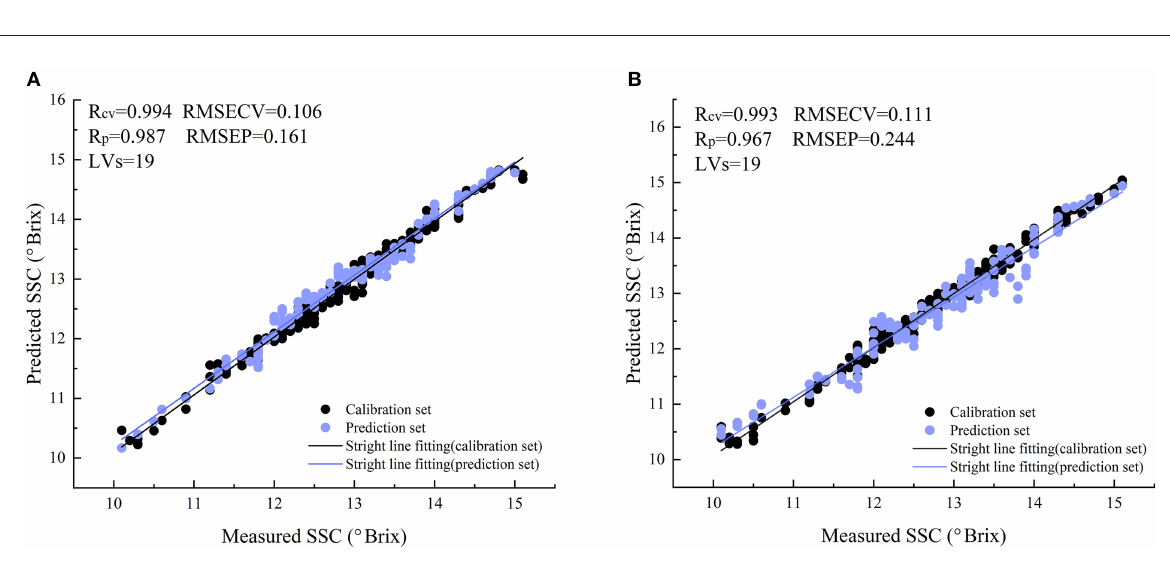
FIGURE7 The correlation diagrams between the measured values of SSC and the predicted values of the models. (A) The static detection of snow peach; (B) The online detection of snow